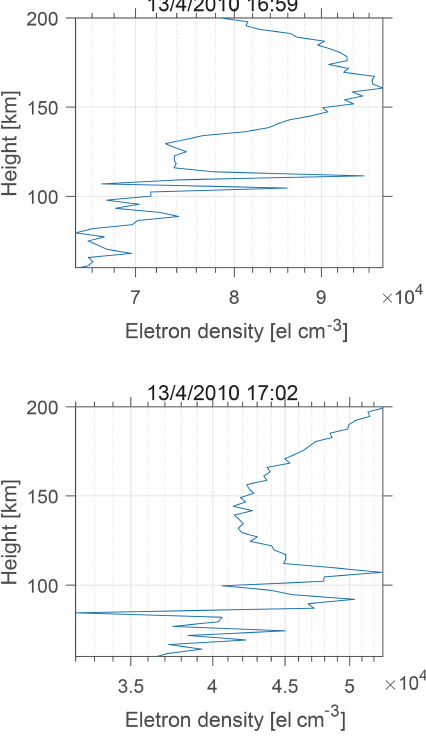
Figure 7. The electron density obtained from COSMIC data on 13 April in the TEC abnormal region.